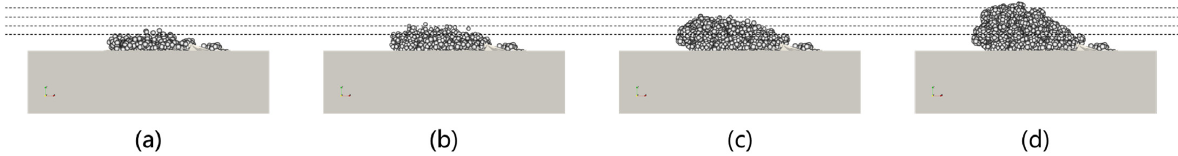
Figure 14. The simulated cladding layers by HOTM: ( a – d ) represent the solidified material by 1,2,3,4 printing, respectively.